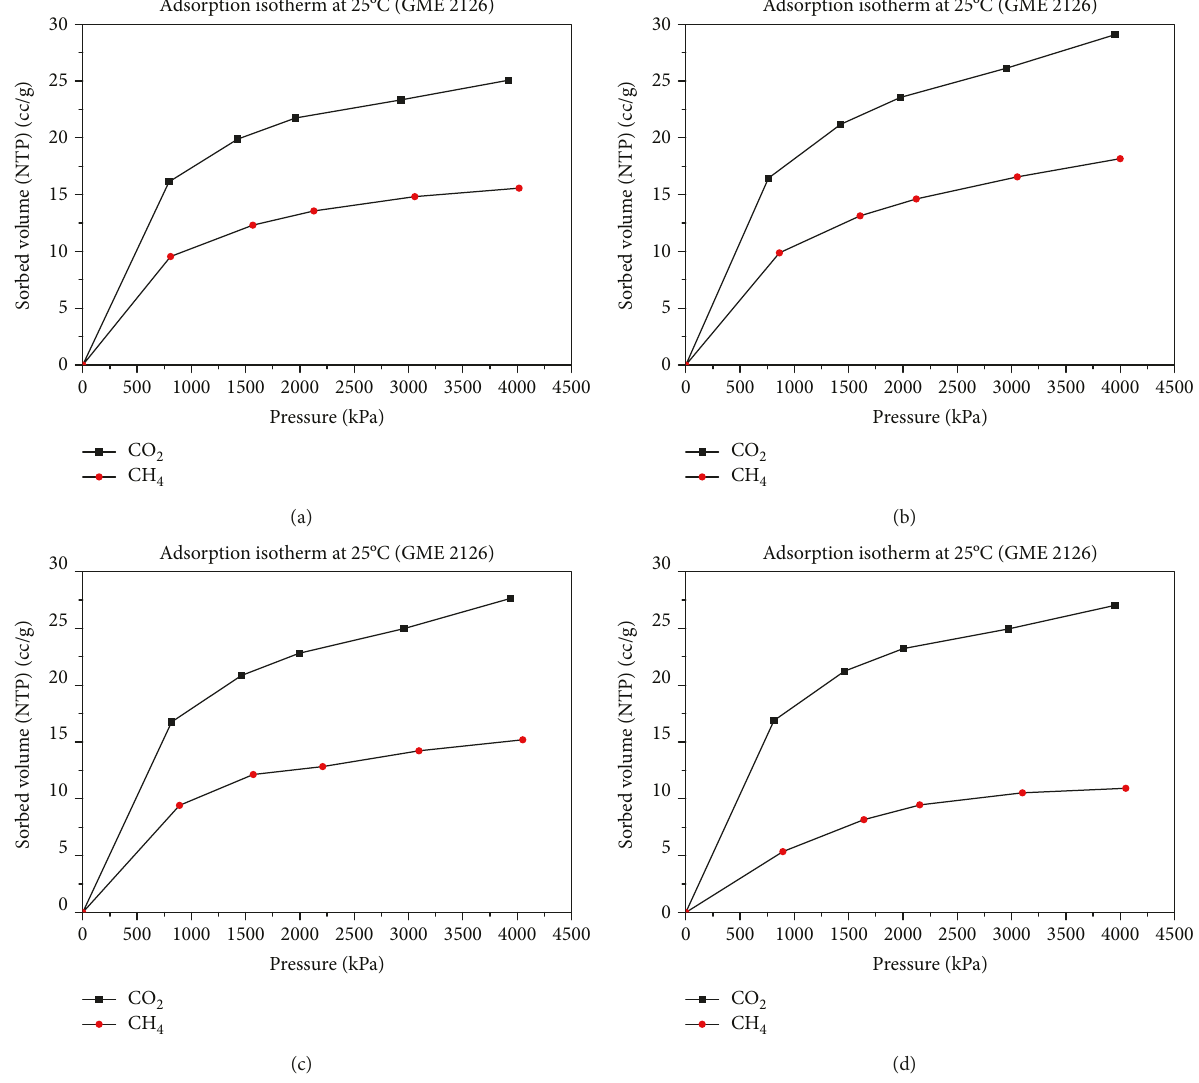
Figure 10: Coal adsorption isotherms at 25 ° C (a, b, c, and d are from typical hard-to-drain areas) (Ref. [45]).